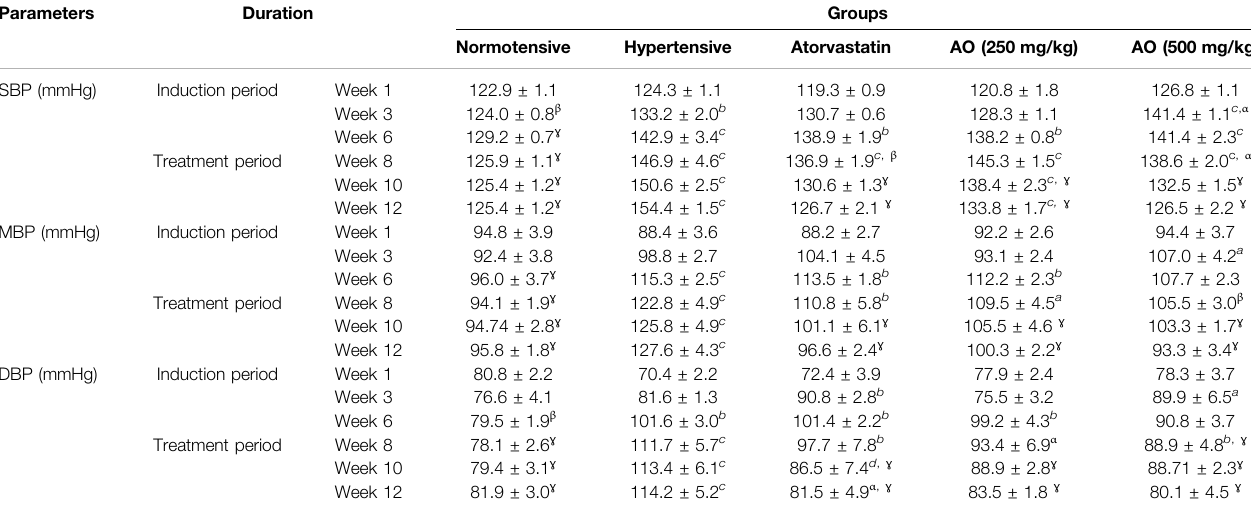
TABLE 4 | Effect of administration of Alpinia of fi cinarum on systolic blood pressure, diastolic blood pressure, and mean blood pressure in obesogenic diet-fed hypertensive rats. Parameters